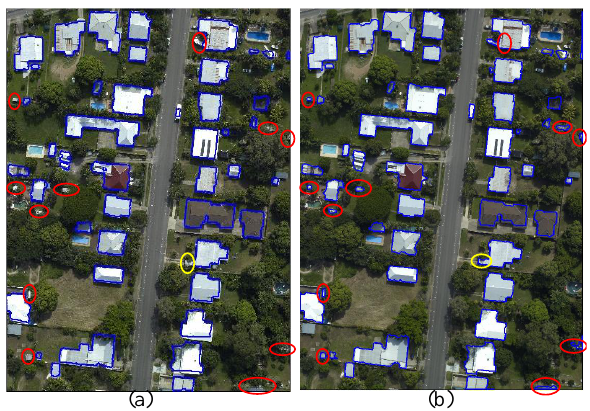
Figure 10. (a) Buildings missed by Awrangjeb(2014) detection technique, (b) Building detection result of proposed